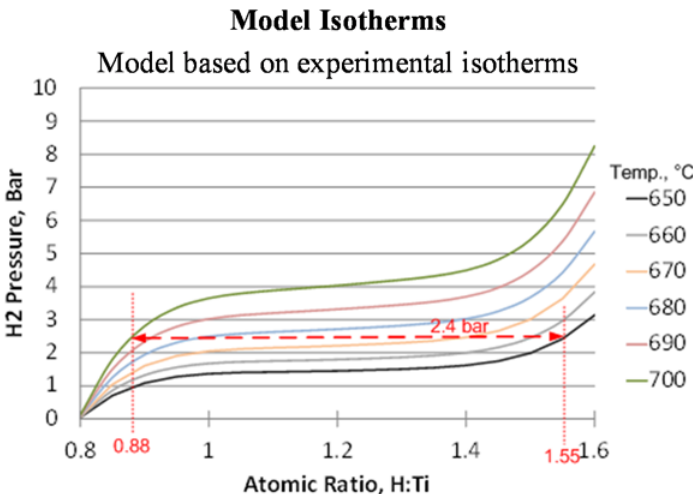
Figure 2. Absorption (Abs) and desorption (Des) isotherms of Ti-sponge at various temperatures. H/M is ratio of moles hydrogen per moles titanium.